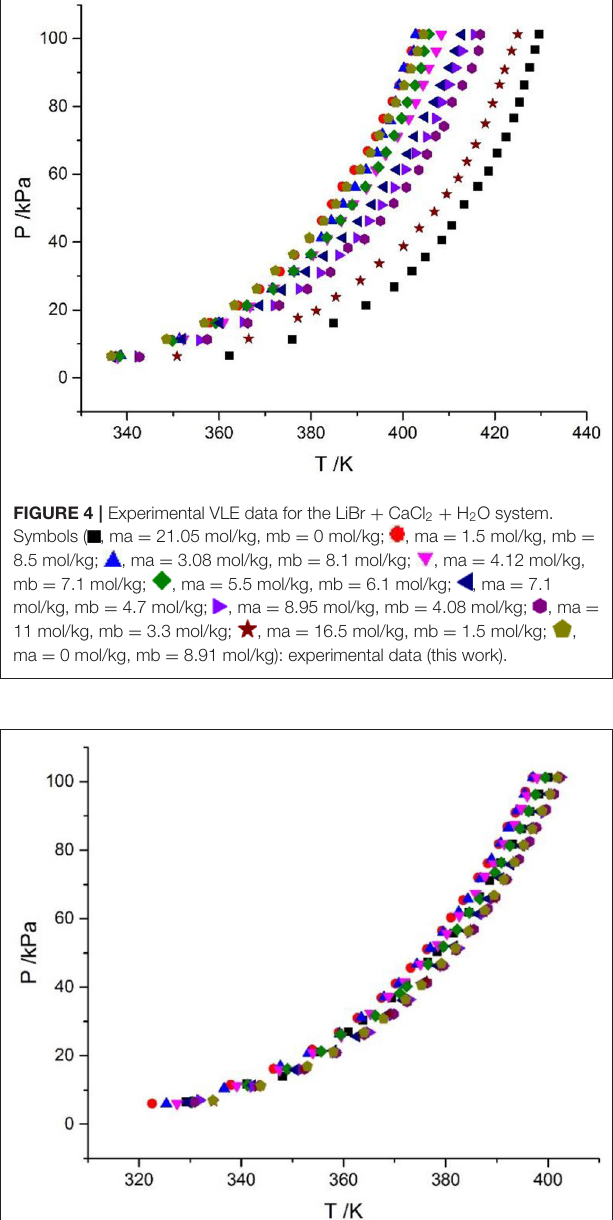
FIGURE 3 | Vapor–liquid equilibrium in the LiBr + H 2 O system. Full symbols ( , m = 21.05 mol/kg; , m = 16.5 mol/kg; , m = 11 mol/kg; , m = 9 mol/kg; , m = 7 mol/kg; , m = 5.5 mol/kg; , m = 4 mol/kg; , m = 3 mol/kg): experimental data.